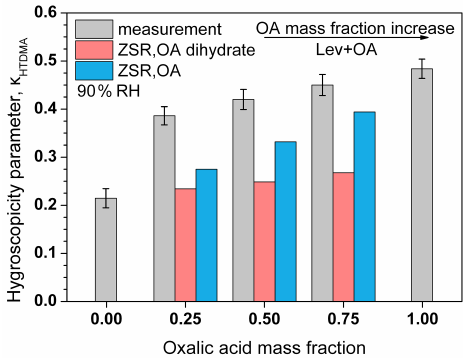
Figure 11. Relationship between O:C and hygroscopicity param- eter κ derived from HTDMA measurements at 90%RH for all the organic aerosol particles in this study.